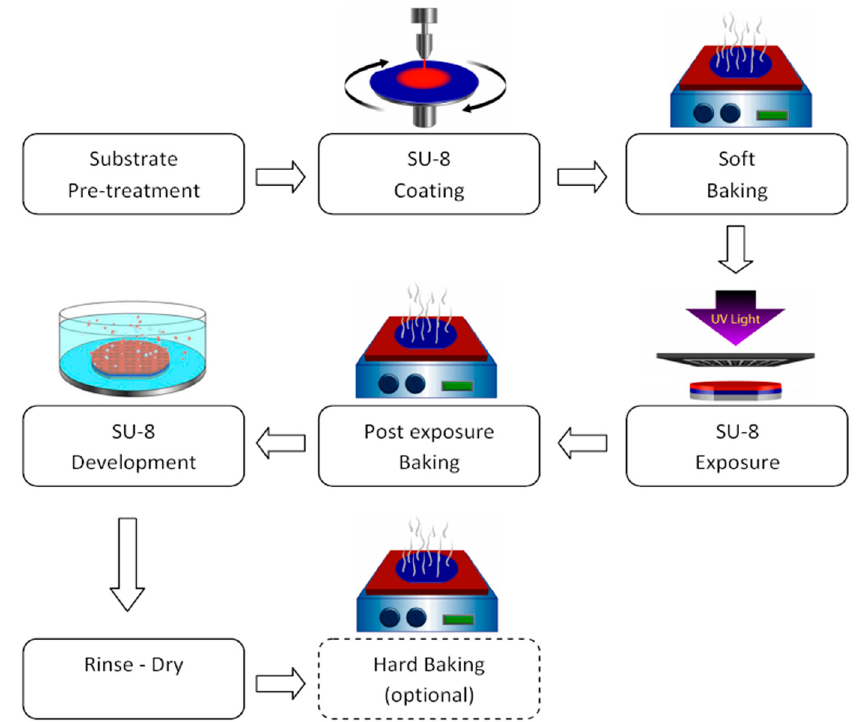
Figure 6. A flowchart of a photolithography process of semiconductor manufacturing industry.